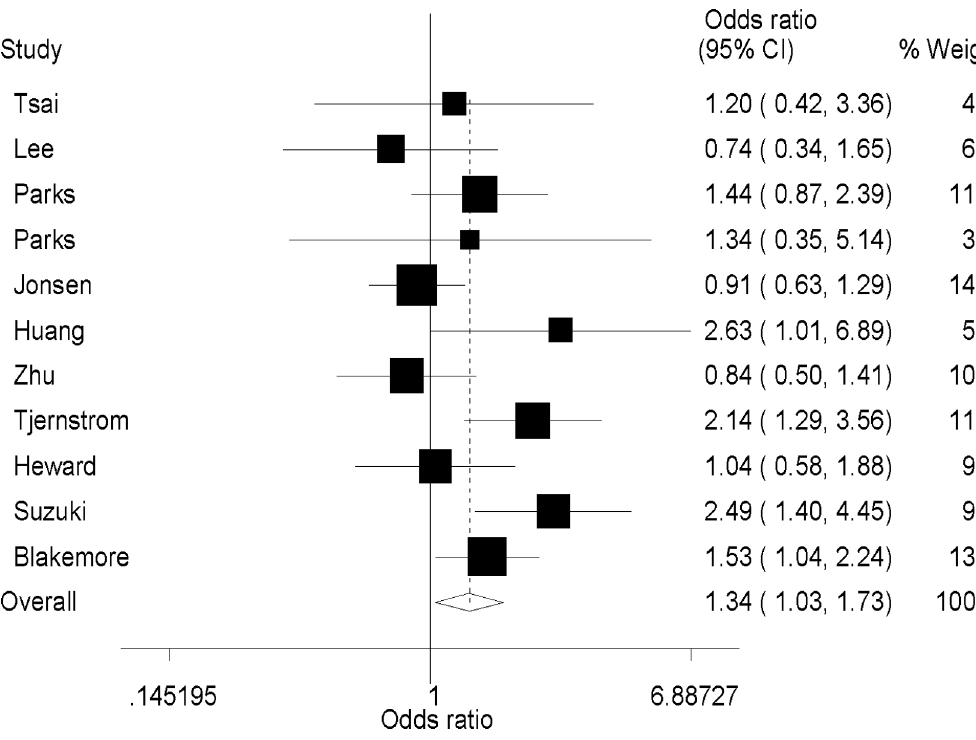
Figure 2. Forest plot of the association between SLE susceptibility and IL1-RN VNTR polymorphism (2 versus L).